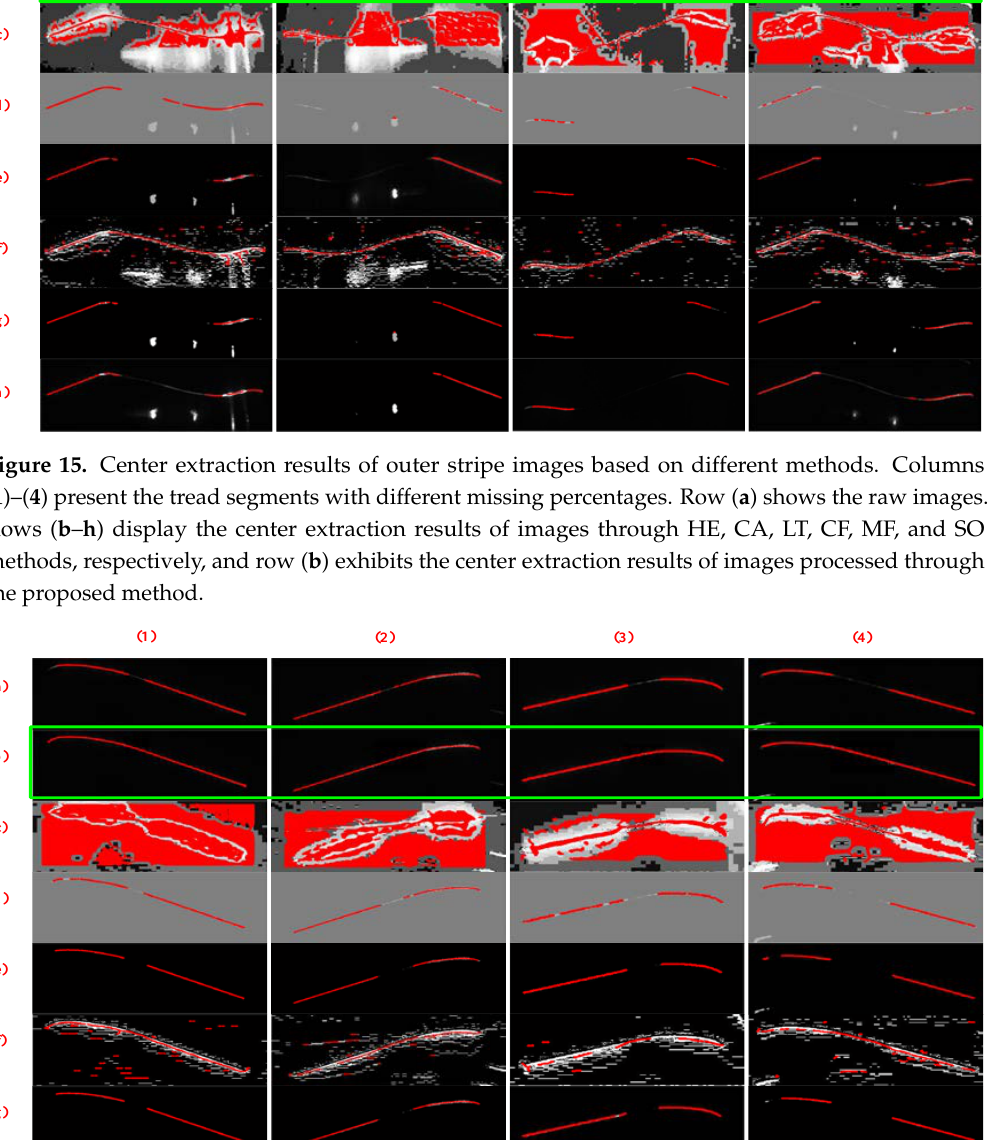
Figure 16. Center extraction results of inner stripe images based on different methods. Columns ( 1 )–( 4 ) present the tread segments with different missing percentages. Row ( a ) shows the raw images. Rows ( b – h ) display the center extraction results of images through HE, CA, LT, CF, MF, and SO methods, respectively, and row ( b ) exhibits the center extraction results of images processed through the proposed method.